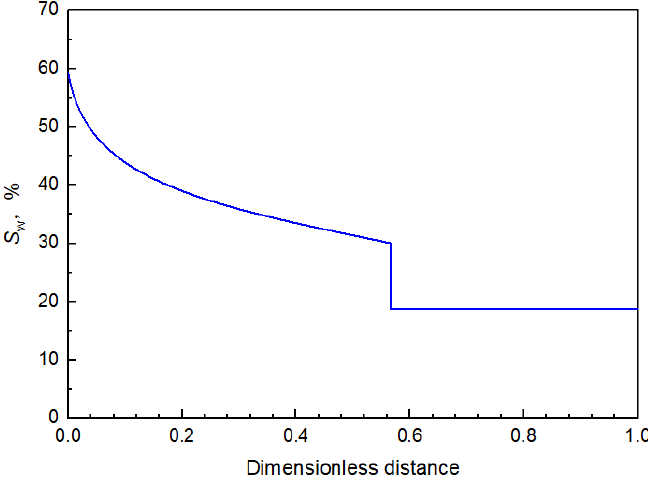
Figure 7. The distribution of water saturation along the way at 0.11 PV injection time.